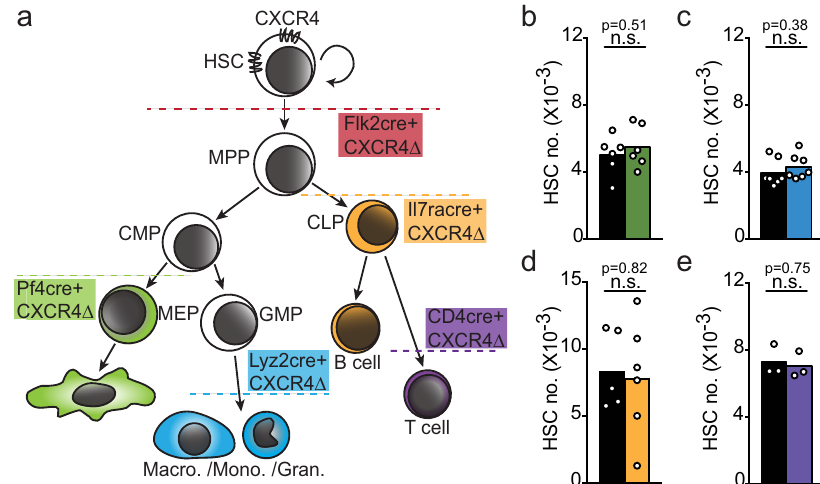
Fig.3|NormalHSCnumbersinmicecarrying Cxcr4 deletioninmegakaryocytes, myeloid, and lymphoid cells. a Schematic representation of CXCR4 deletion in hematopoietic cells by cell-lineage speci fi c cre-recombinase transgenic approa- ches. b – e LT-HSCnumbersinonefemurandtibiaofcontrollittermatemice(black); ( b ) Pf4-cre.Cxcr4 fl / fl (green, n =6/group); ( c ) Lyz2-cre.Cxcr4 fl / fl (blue, n =7/group); ( d )